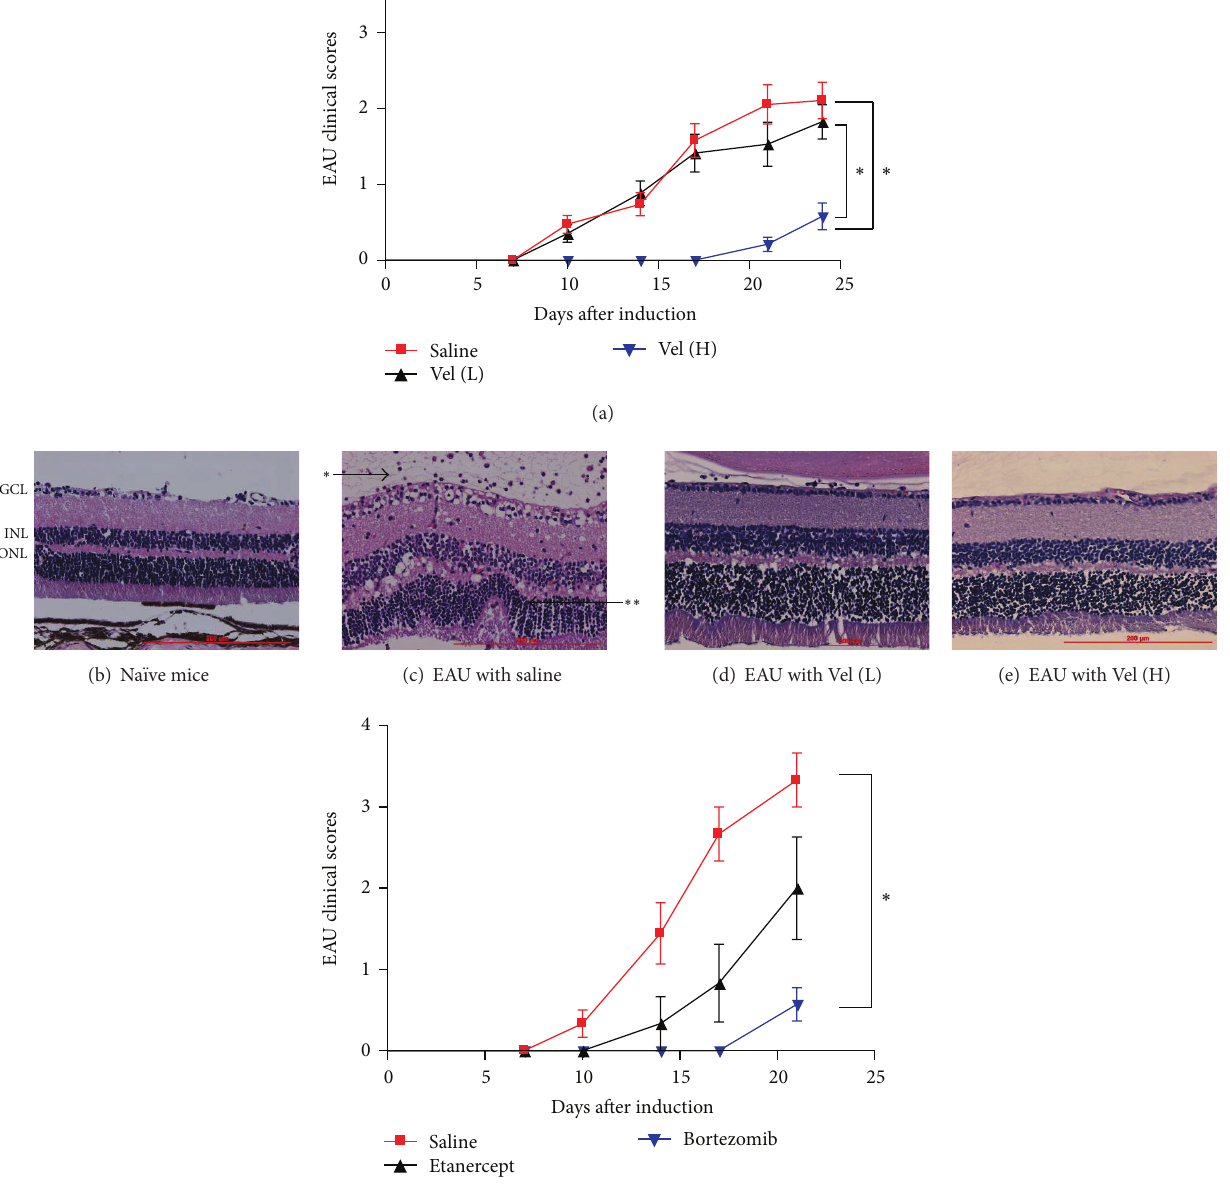
Figure 1: Effect of bortezomib on clinical course of EAU induced with IRBP. (a) Comparison of clinical scores of EAU mice treated with high-dose (0.75 mg/kg) bortezomib (red line, 𝑛 = 19 ), low-dose (0.15 mg/kg) bortezomib (black line, 𝑛 = 17 ), or PBS (blue line, 𝑛 = 19 ) in 0.1mL. Data shown are the mean clinical score (ordinate) of each experiment group over time (abscissa) and the sum of three independent experiments. Comparison of (the course of the clinical symptoms) high-dose bortezomib-treated EAU mice (blue line) with saline-treated mice (red line) shows a significant difference and is indicated as ( ∗ ). Comparison of high-dose bortezomib-treated (blue line) with low-dose bortezomib-treated (black line) EAU mice also shows a significant difference and is indicated as ( ∗ ). ∗ 𝑃 < 0.05 , via the Wilcoxon signed- rank test. (b), (c), (d), and (e): photomicrographs of H&E stained retinal tissue. Representative photomicrographs of paraffin-fixed H&E stained slides of the retina of (b): na¨ıve C57BL/6 mice without EAU induction, (c): EAU mice that received 0.1mL PBS treatment ( ∗ indicates leukocytes in vitreous cavity; ∗∗ indicates retinal folds), (d): EAU mice that received low-dose (0.15 mg/kg) bortezomib treatment, and (e): EAU mice that received high-dose (0.75 mg/kg) bortezomib treatment. The experiment was repeated three times with similar results. GCL: ganglion cell layer. INL: inner nuclear layer. ONL: outer nuclear layer. (f) Average clinical score over time of EAU in mice with high-dose (0.75 mg/kg) bortezomib (blue line, 𝑛 = 9 ), etanercept (5 mg/kg) (black line, 𝑛 = 6 ), or saline (0.1mL/mouse) treatment (red line, 𝑛 = 7 ). Data shown are the mean clinical score (ordinate) of each experiment group over time (abscissa) and the sum of two independent experiments. ∗ 𝑃 < 0.05 , via the Wilcoxon signed-rank